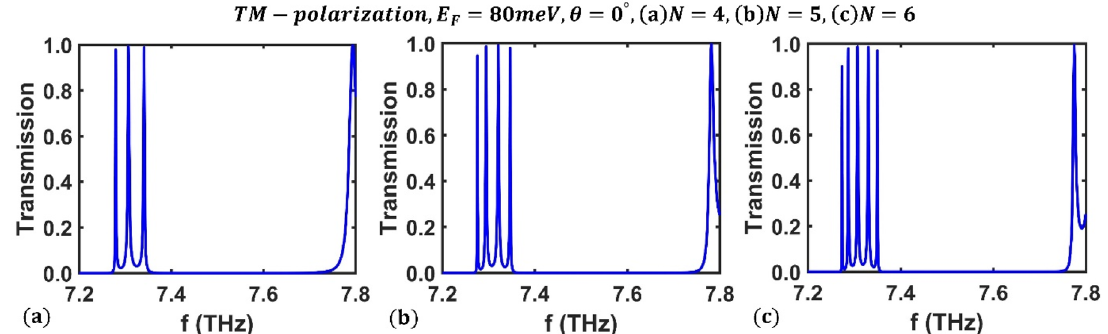
Figure 13. The transmission spectrum of the third-order F-1D PhC structure for TM polarization state under normal incidence corresponding to Fermi energy E F = 80 meV and different period numbers ( a ) N = 4 , ( b ) N = 5 and ( c ) N = 6